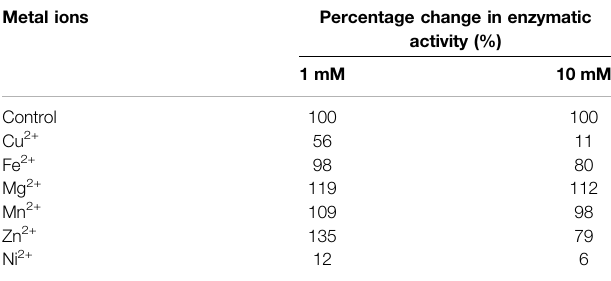
TABLE 2 | Percentage change in enzymatic activity of recombinant chitin deacetylase ChDaII from Mucor circinelloides IBT-83. The culture medium obtained after 48 h of cultivation of the selected transformant was used as the enzyme preparation. Metal